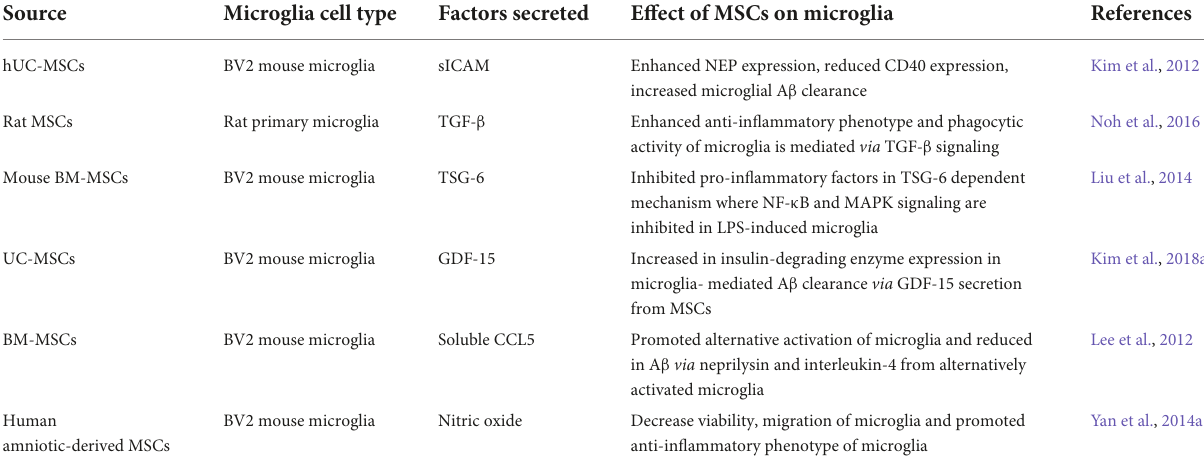
TABLE 3 Studies exploring factors governing the neuroprotective/immunomodulatory effect of